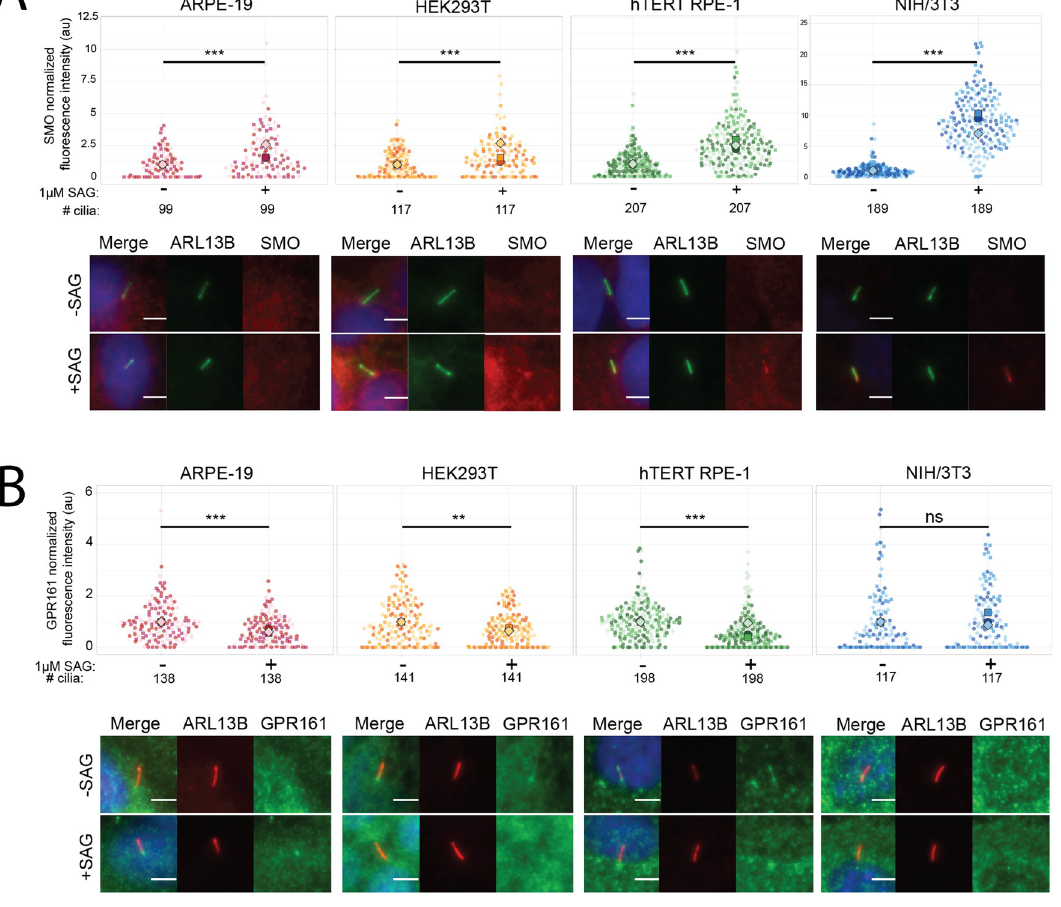
PLOS ONE | https://doi.org/10.1371/journal.pone.0266433 December29,